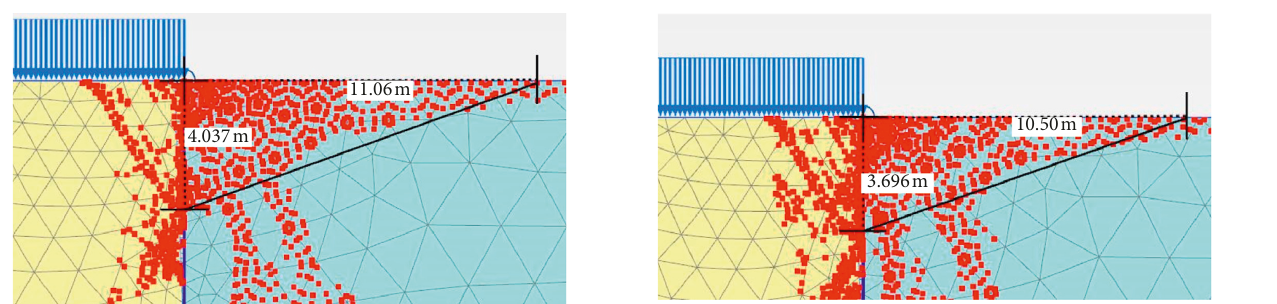
Figure 13: Distribution of failure points inside the foundation pit at φ � 25 ° .